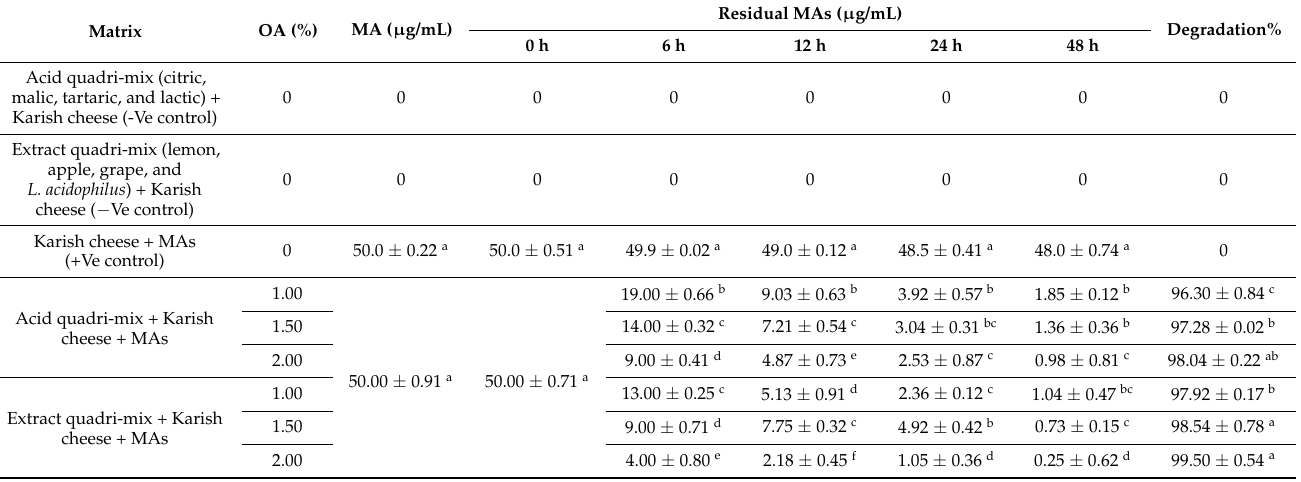
Table 3. Mycolic acid degradation efficiency by acid quadri-mix and extract quadri-mix in Kar- ish